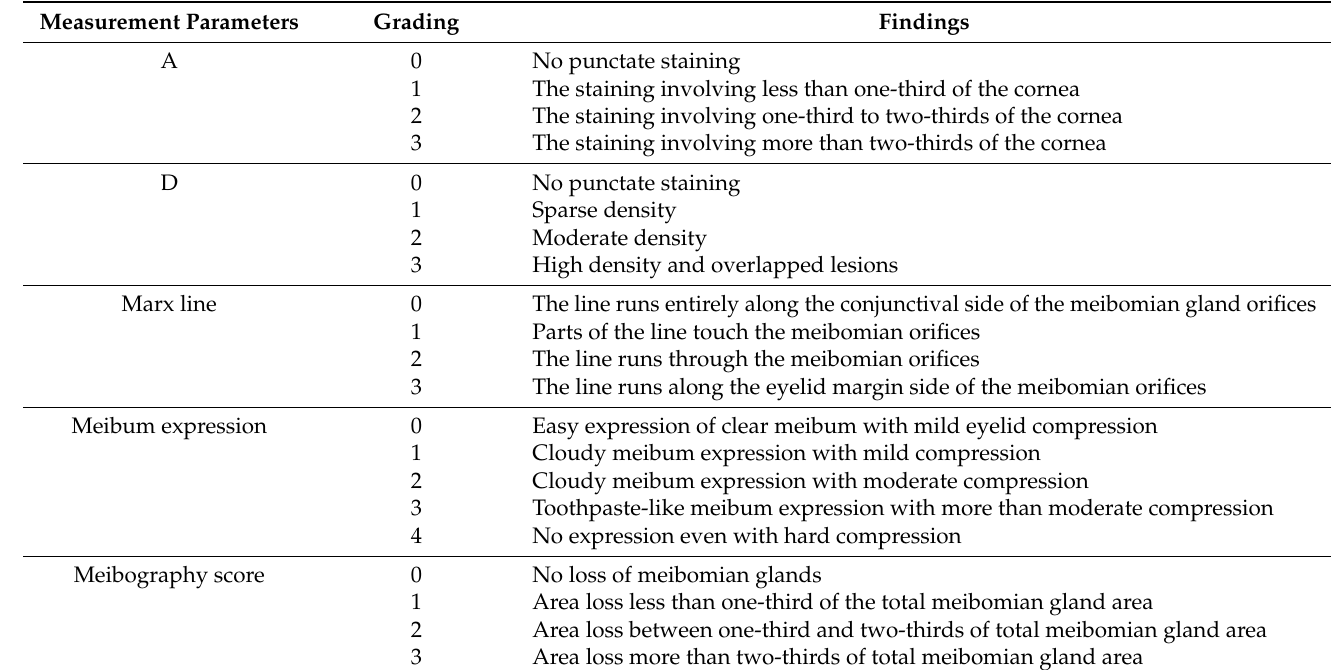
Table 1. The grading systems of measurement